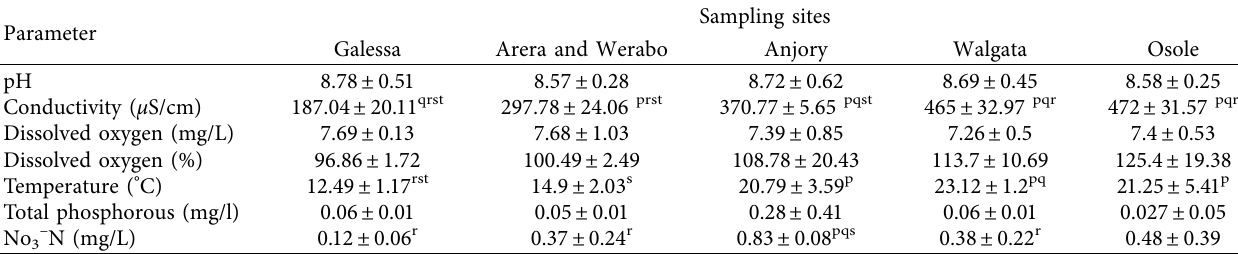
Table 1: Means and standard deviations for environmental parameters of the study sites.